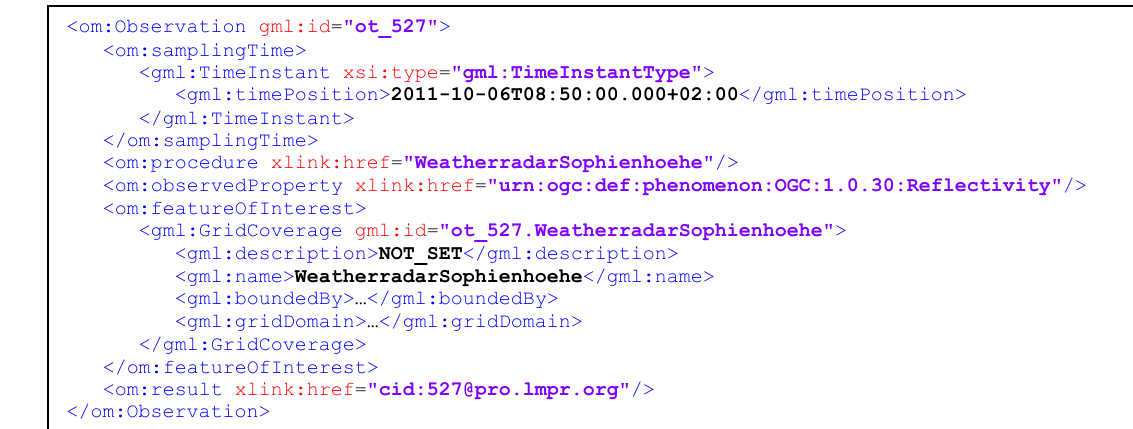
Figure 8. O&M response XML fragment where the data is linked by a